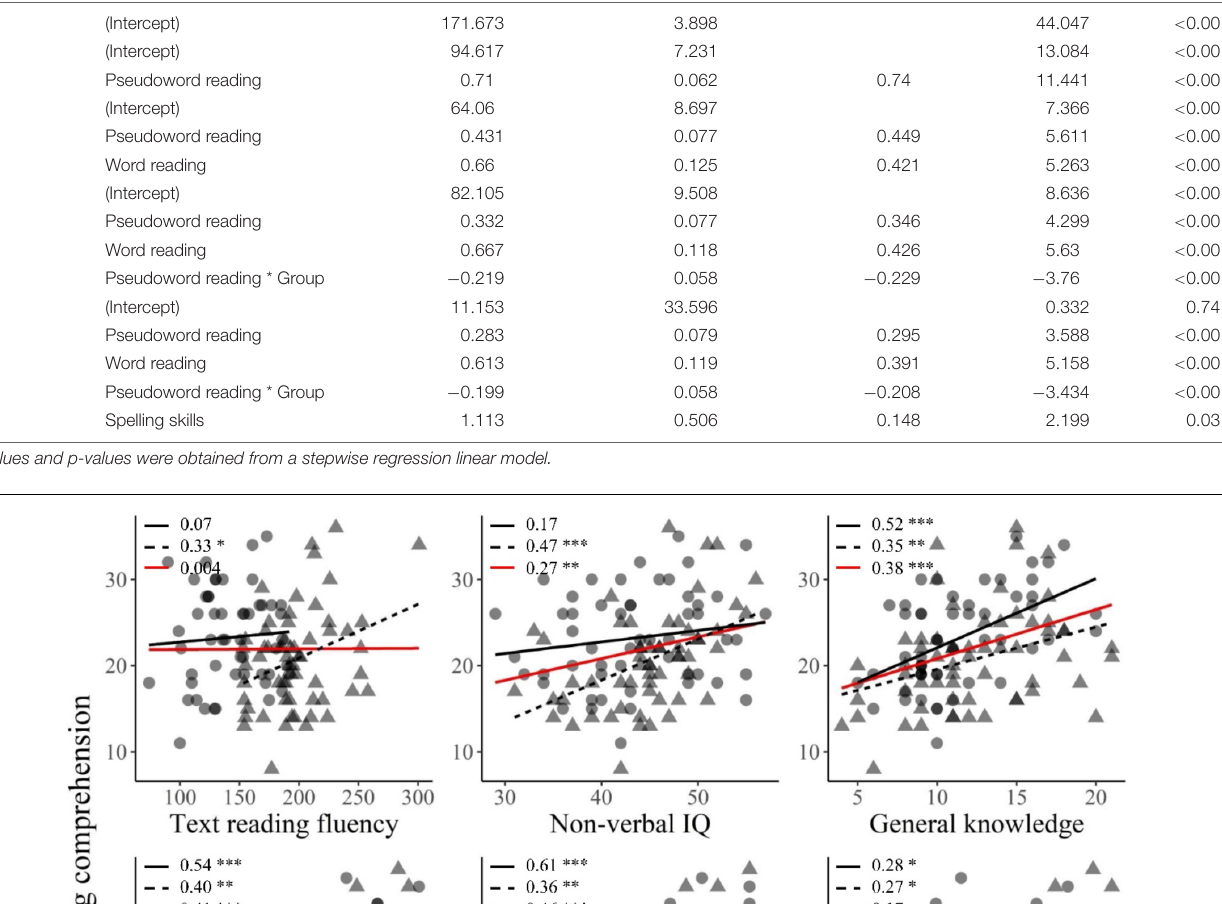
p < 0.05; SR: r = 0.27, p < 0.05), but not when both populations were considered ( r =